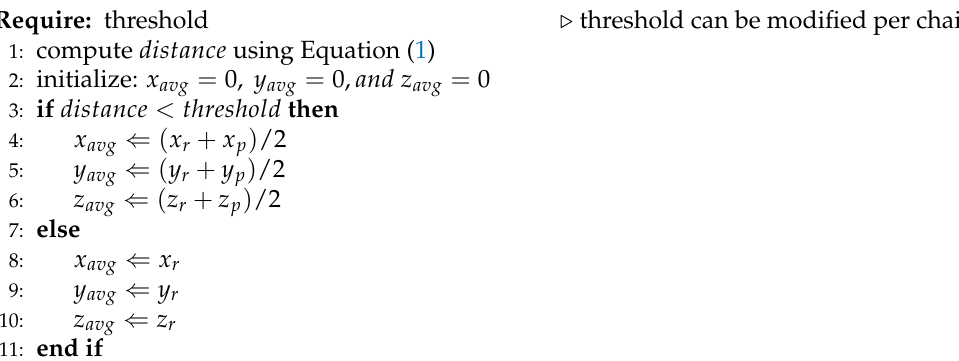
Algorithm 1 Average predicted structure and reference structure.